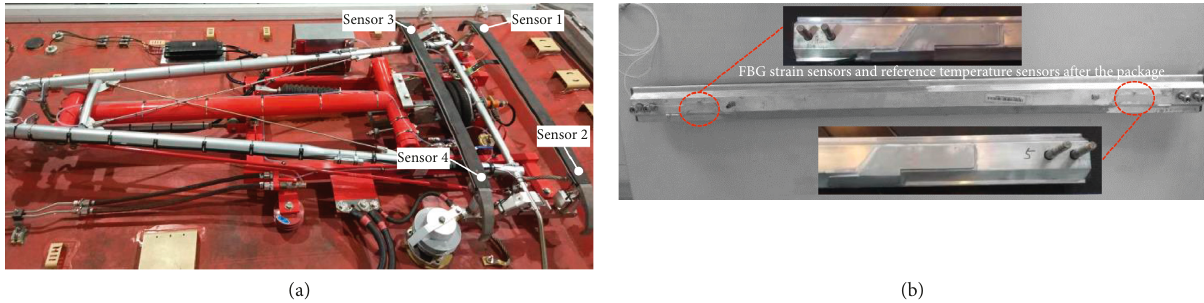
Figure 3: Sensor configuration (sensors 1–4 are the FBG strain sensors and their reference temperature sensors after the package).